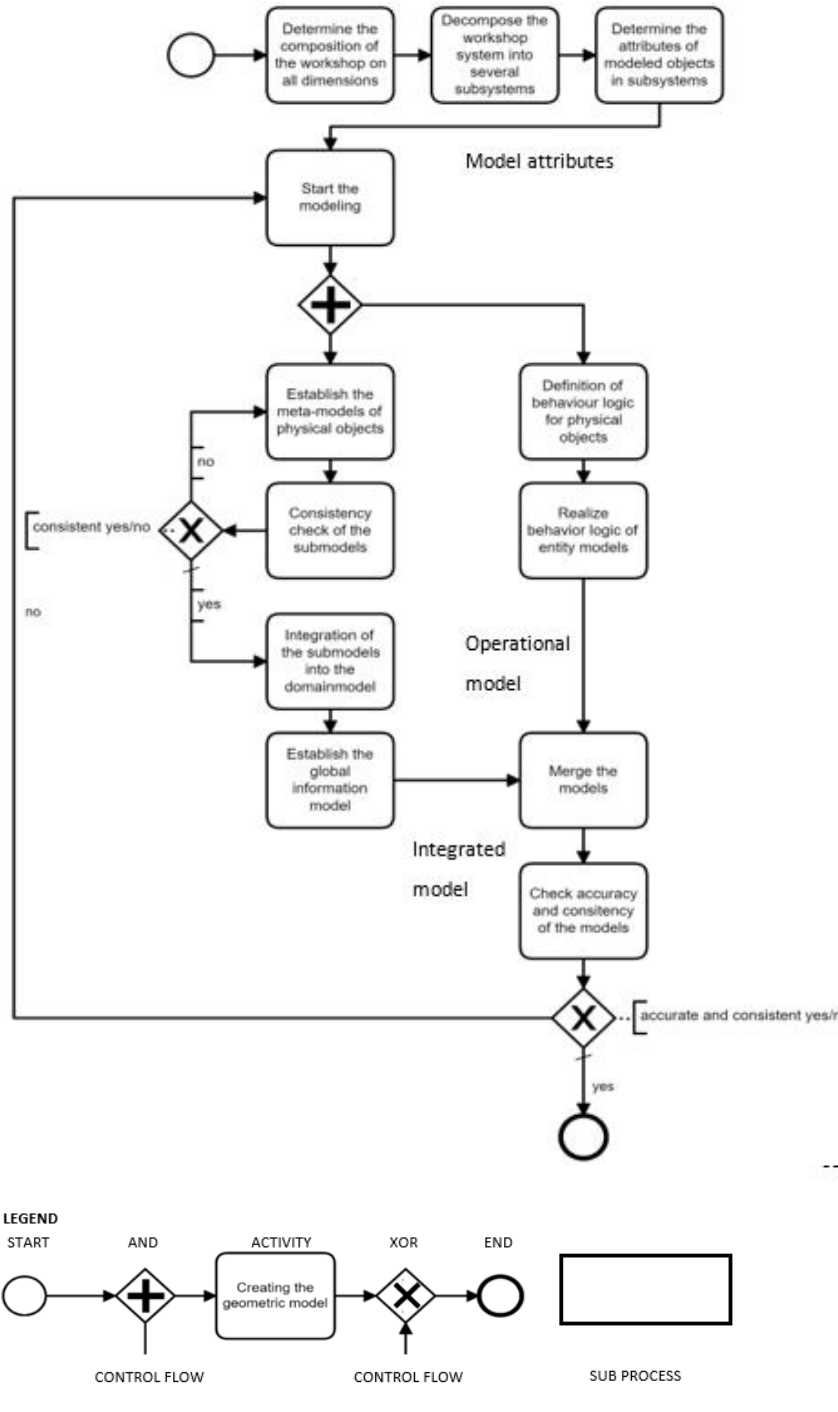
Figure 4. The sequence of steps (i.e., process model) of Product Lifecycle Management for imple- menting a product life cycle, specified in an enriched Business Process Model & Notation (BPMN) (https://www.bpmn.org/ accessed on 30 June 2022), data derived from